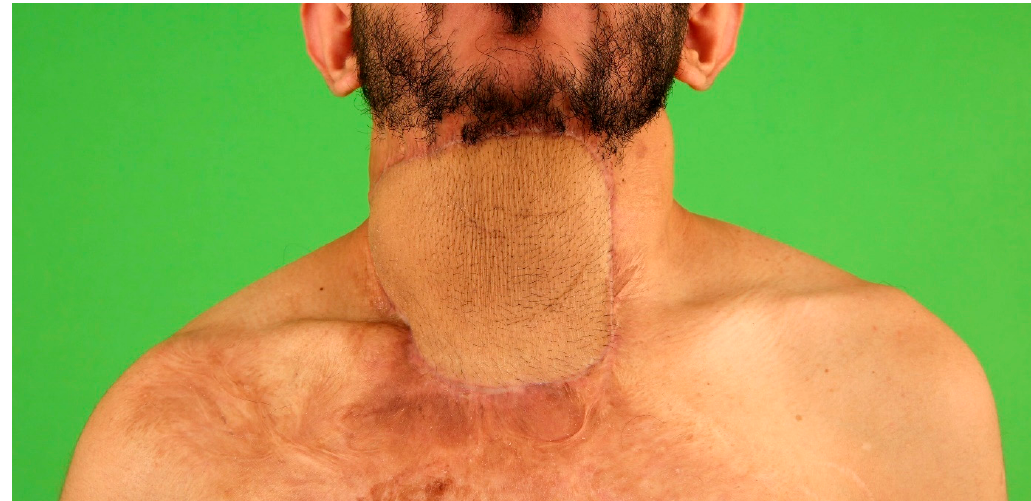
Figure 6. Postoperative result one year after flap transfer. The neck contracture is entirely released, with normal neck movement and pleasant aesthetic outcome.